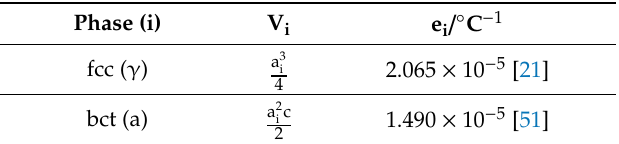
Table 3. Specific atomic volume, V i , and thermal expansion coe ffi cients, e i , of the di ff erent unit cells used in this work, i. Their corresponding lattice parameters are denoted by a i , and c i . T stands for the temperature in ◦